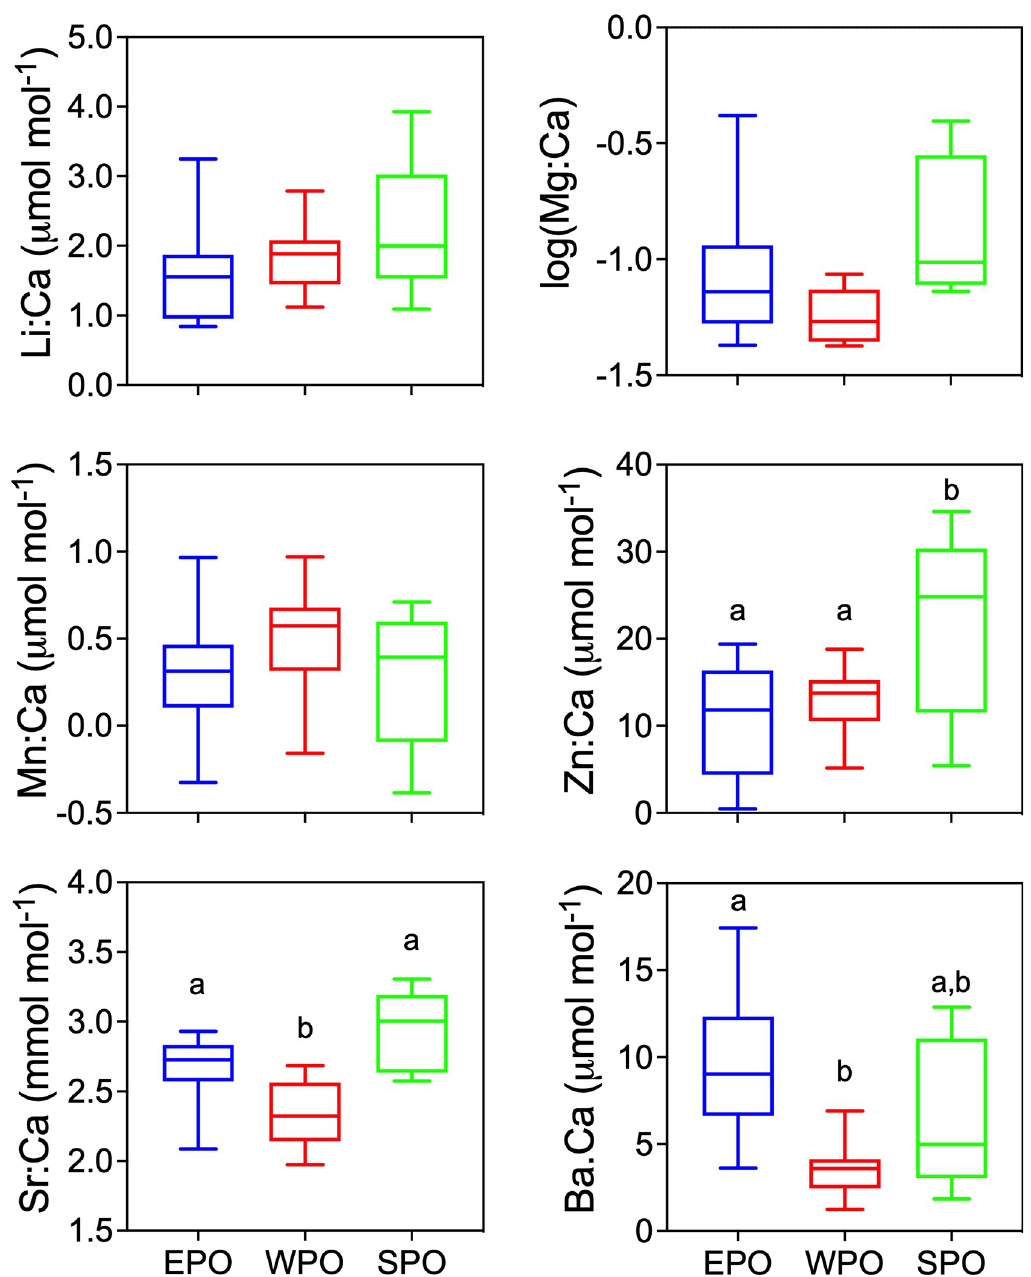
Fig 4. Boxplots of otolith edge values (mean of final 100 μ m) for each region. EPO = blue, WPO = red, SPO = green. One- way ANOVA significant differences (see Table 1) among regions were further tested with a Holm-Sidak multiple comparison test with lower case letters indicating regions that are significantly different; regions that were not significantly different share the same lower case